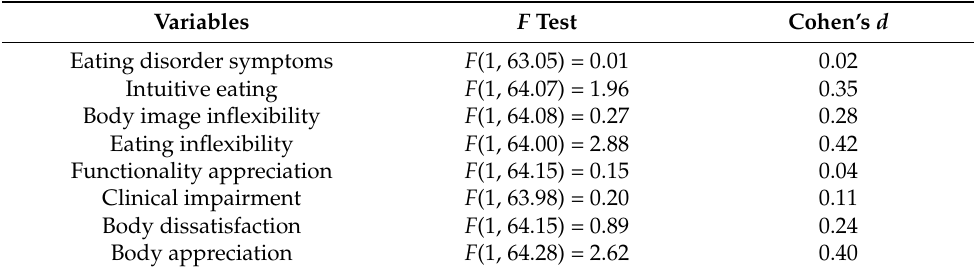
Table 4. Interaction between intervention effects and type (online vs.